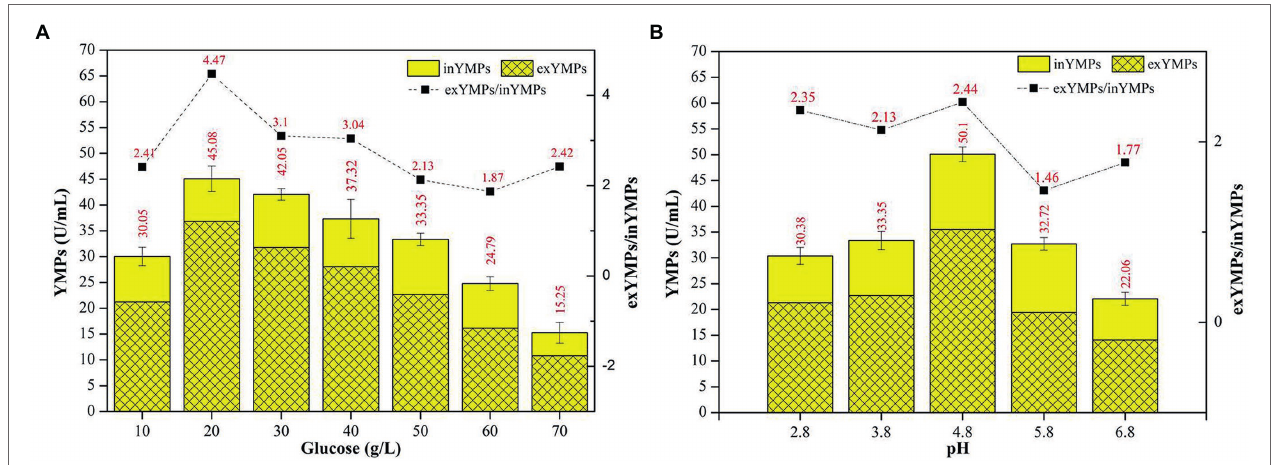
FIGURE 2 | The effect of initial glucose concentration (A) and pH (B) in the fermentation broth on the production of yellow monascus pigments (YMPs) and the ratio of extracellular YMPs to intracellular